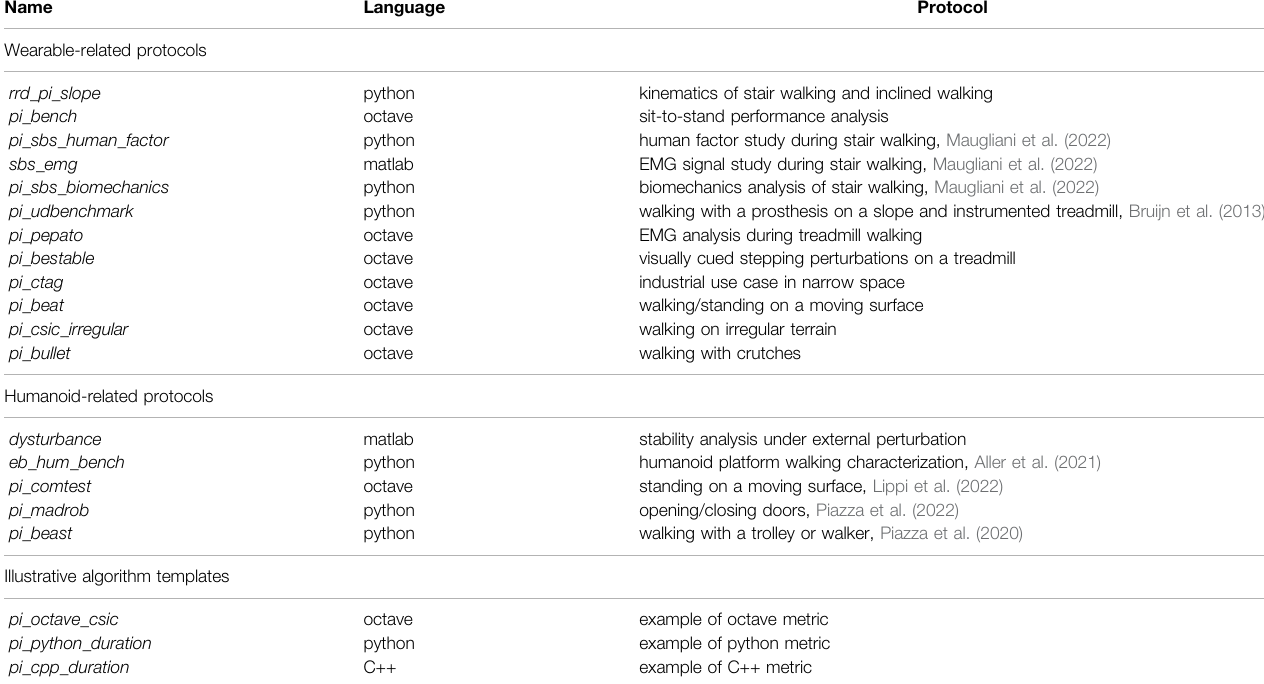
TABLE 1 | List of protocol metrics following Eurobench format.